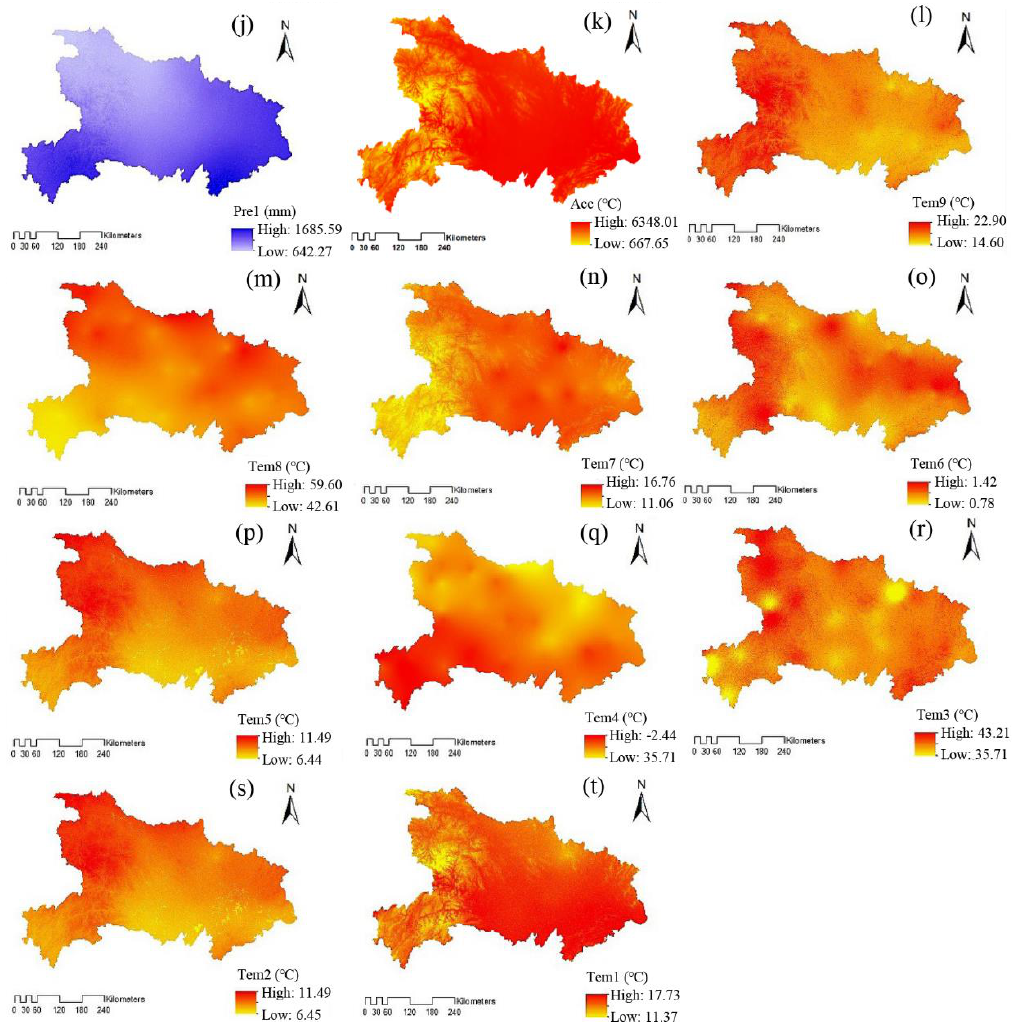
Figure A1. Spatial distribution map of site factors. ( a ) DEM represents digital elevation model; ( b ) spatio-temporal of aspect; ( c ) spatio-temporal of slope; ( d ) Pressure represents air pressure; ( e ) spatio-temporal of frost; ( f ) spatio-temporal of humidity ( g ) Pre4 represents relative standard deviation of precipitation; ( h ) Pre3 represents precipitation of the driest month; ( i ) Pre2 represents rainfall of the wettest season; ( j ) Pre1 represents annual precipitation; ( k ) Acc represents accumulated temperature; ( l ) Tem9 represents isothermality; ( m ) Tem8 represents temperature annual range; ( n ) Tem7 represents temperature standard deviation; ( o ) Tem6 represents minimum daily temperature; ( p ) Tem5 represents poor annual temperature; ( q ) Tem4 represents the min temperature of the coldest month; ( r ) Tem3 represents the max temperature of the hottest month; ( s ) Tem2 represents annual diurnal range and ( t ) Tem1 represents annual mean